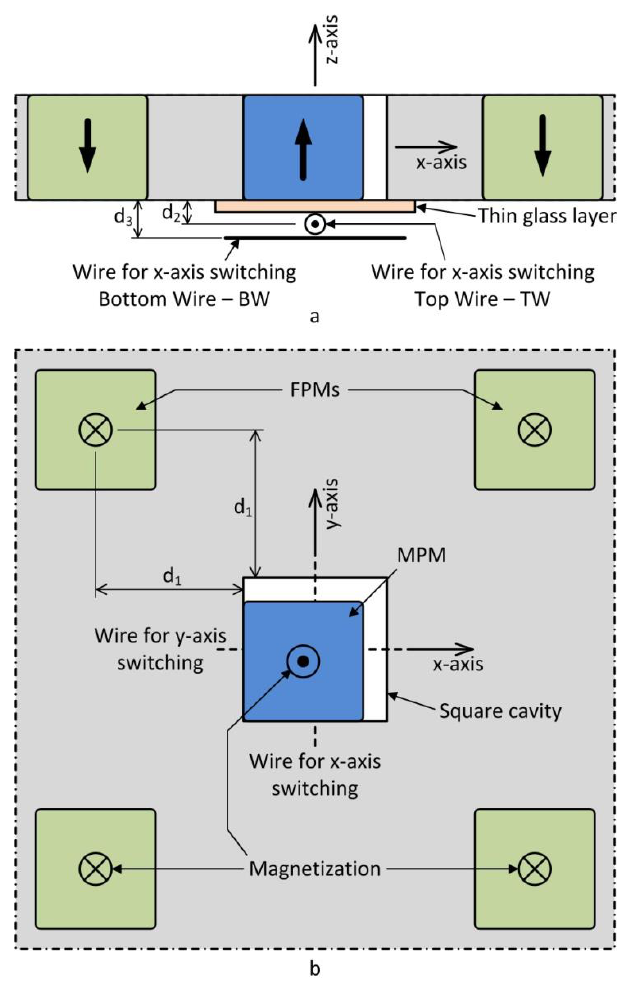
Figure 1. Principle of the four discrete positions actuator: ( a ) side view, and ( b ) top